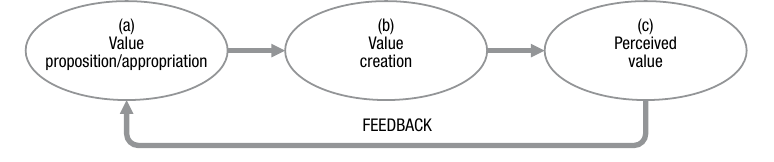
Fig. 2. Customer value